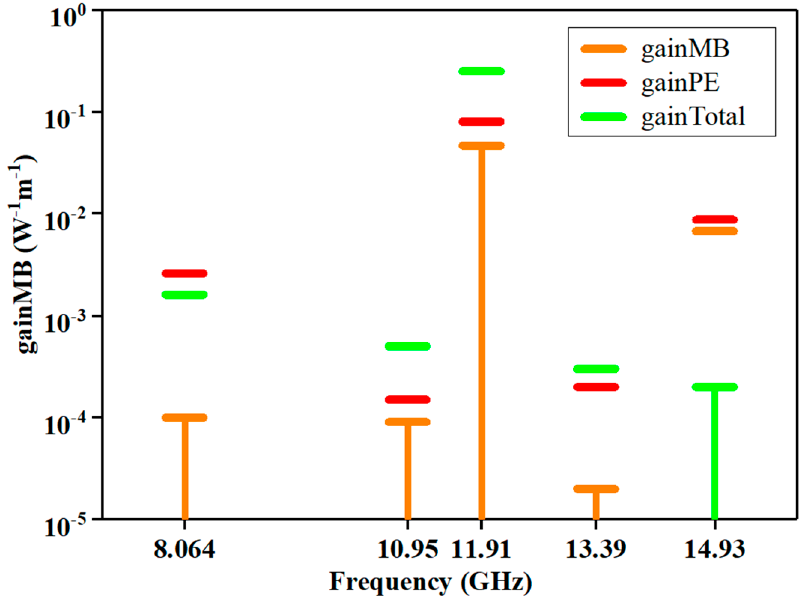
Figure 4. Contribution of different effects to the BSBS gain coefficient in the stimulated Brillouin scattering process, including the moving boundary effect (orange short line), radiation pressure effect (red short line) and the entire Brillouin contribution of gain (short green line) when the waveguide width w = 2818 nm.